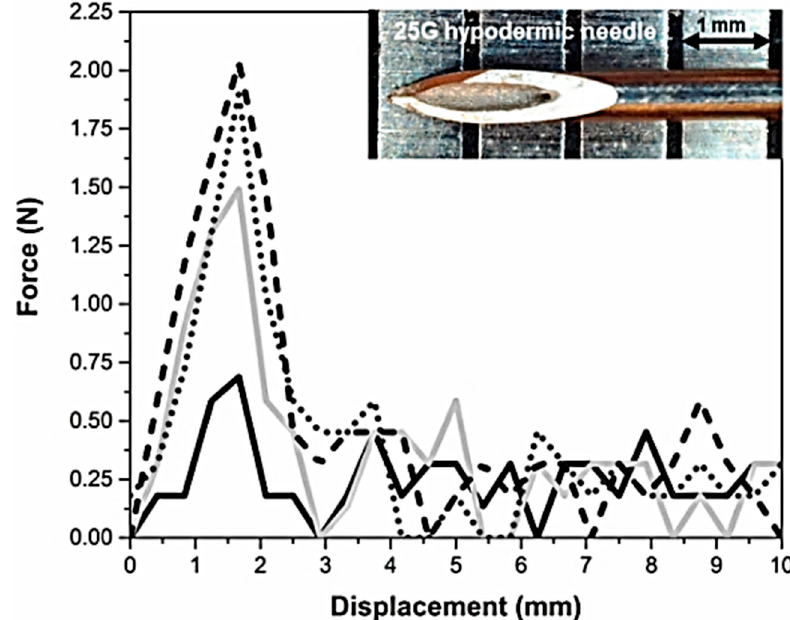
Figure 7. Force-versus-displacement graphs from the 25G needlestick penetration test on single-layer plasma-treated UHMWPE fabric samples: ― , neat; ― , coated with PU; •••, coated with 30 wt.% SiC in PU; ‒ ‒ ‒ , coated with 50 wt.% SiC in PU.